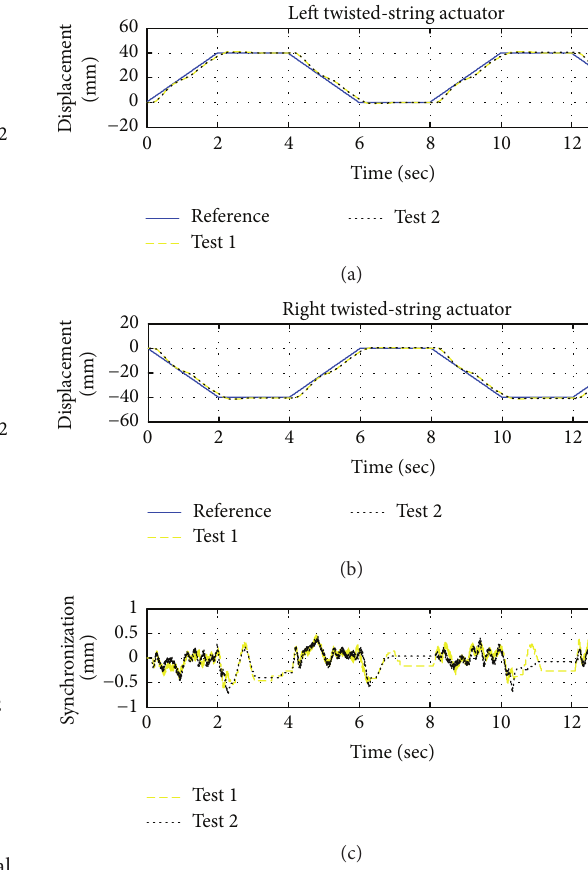
Figure12:ExperimentaloutcomeofPID-FCcontroller(trapezoidal motion): (a) comparison between reference trajectory and actual trajectories of left actuator; (b) comparison between reference tra- jectory and actual trajectories of right actuator; (c) synchronization errors between left and right twisted